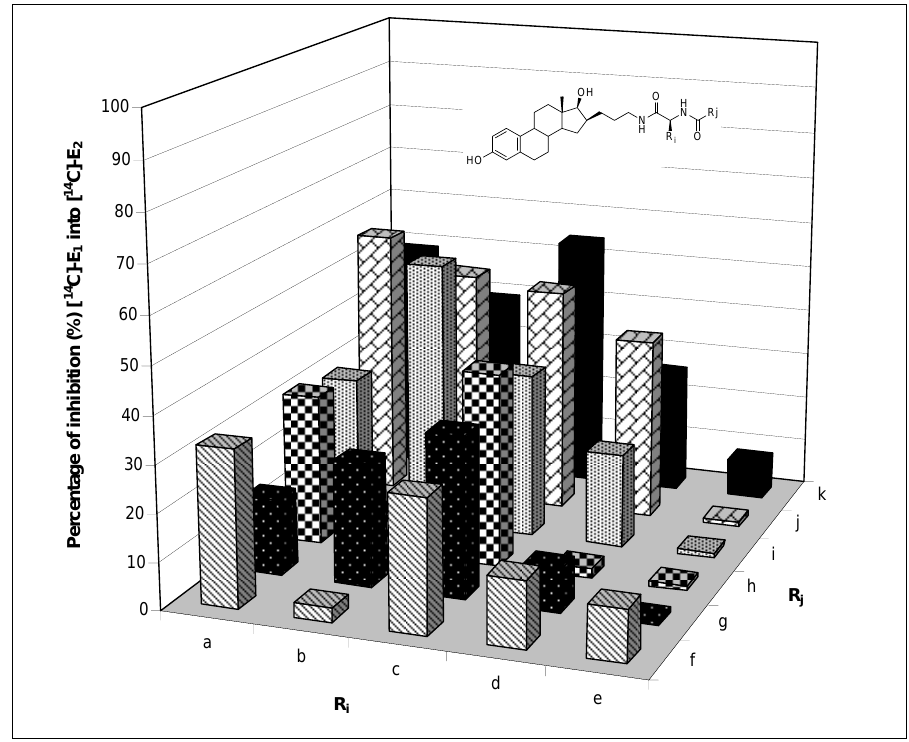
(0.1 µM) into [ 14 C]-E in homogenated HEK- 1 2 derivatives of library B (compounds 59–88 ) at 1 µM. The 2 and R ) on side chain (see Scheme 3). See experimental i j